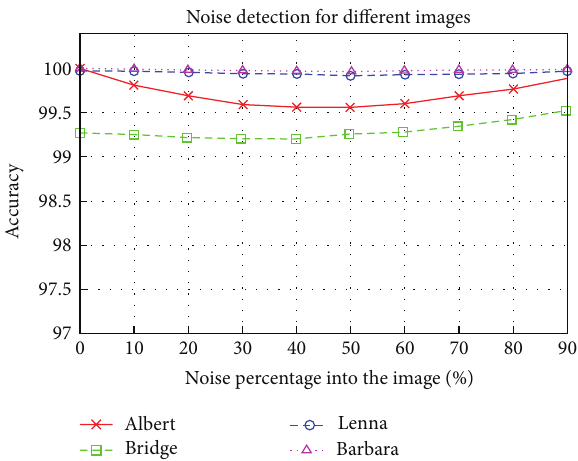
Figure 6: Detection results for the images used in our